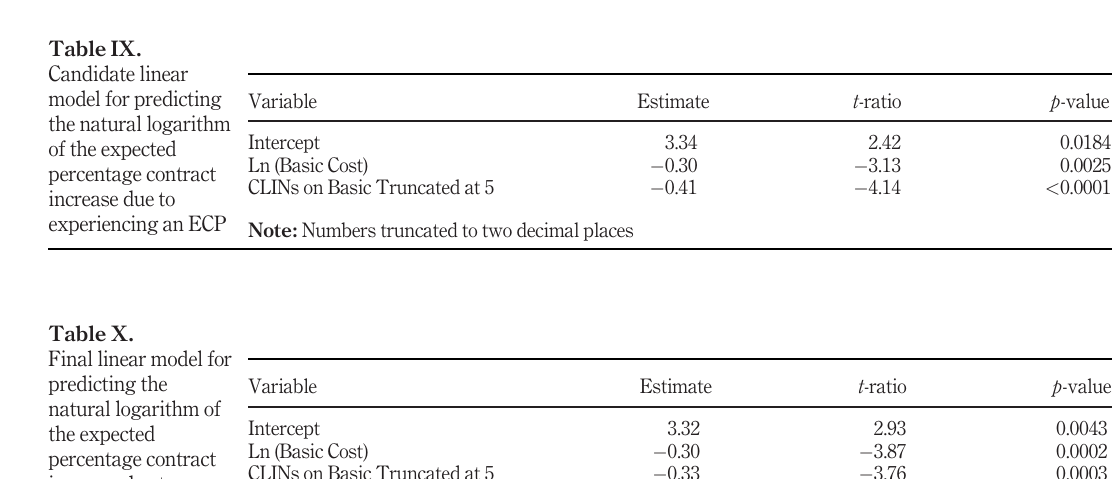
Table IX highlights the preliminary model for predicting the expected natural log percentage increase in contract cost because of an ECP. The model has an R 2 of 0.37 and an adjusted R 2 of 0.35, respectively. No other explanatory variable proved statistically signi fi cant after accounting for the cost of the basic contract along with the number of CLINs truncated at fi ve (that is fi ve or more CLINs are grouped into the fi ve CLIN group). In no iteration did the F18 variable prove statistically signi fi cant, similar to the fi ndings of the logistic model. The candidate model in Table IX passed all model diagnostics with no issues with multicollinearity (largest VIF score of 1.13), outliers (largest studentized residual value of 2.5), in fl uential datapoints (largest Cook ’ s D value of 0.13), normality (Shapiro – Wilk test p -value of 0.47) or constant variance (Breusch – Pagan test p -value of 0.50). For the OLS model, for both the modeling and validation datasets, the MAPE and MdAPE are 86 per cent and 35 per cent and 130 per cent and 36 per cent, respectively. The higher MAPEs in comparison to the lower MdAPEs re fl ects moderate outliers in both datasets, while the relative comparable MdAPEs are a better measure of the model ’ s consistency and generalization. Table X highlights the fi nal empirical model after updating with the validation dataset and used in conjunction with the results of the previously presented logistic models. Equation (1) represents the user model in mathematical form, taking into consideration back-transformation. Note: a user would only use equation (1) for any contract whose baseline cost exceeds $100,000 but is less than or equal to $164m (both in BY $16). Otherwise, the expected median percentage would be zero given a very, very low chance of lower cost contracts (equal to or less than $100,000) incurring an ECP: